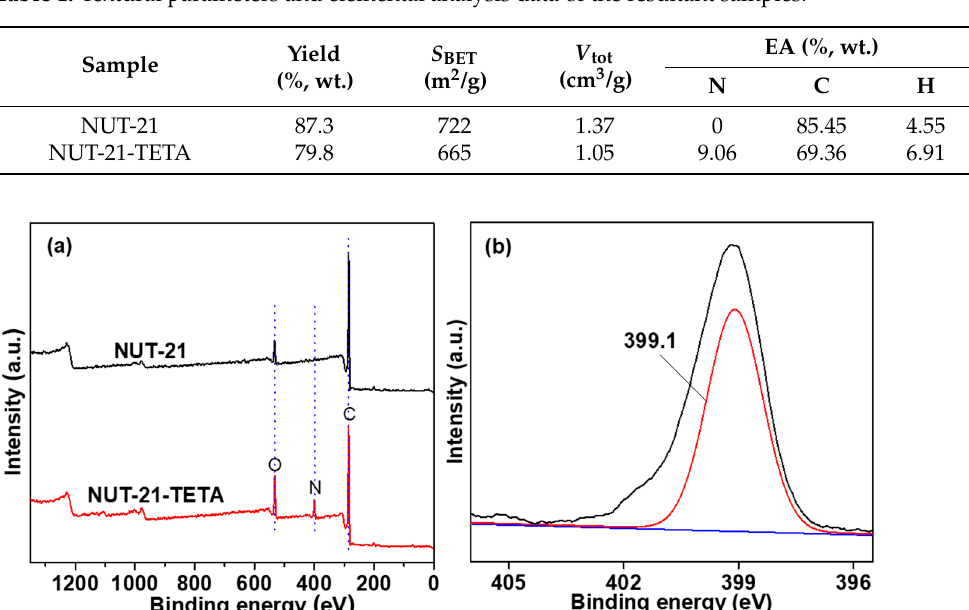
Figure 2. ( a ) XPS wide spectra of the NUT-21 and NUT-21-TETA, ( b ) XPS N 1s spectra of the NUT- 21-TETA.